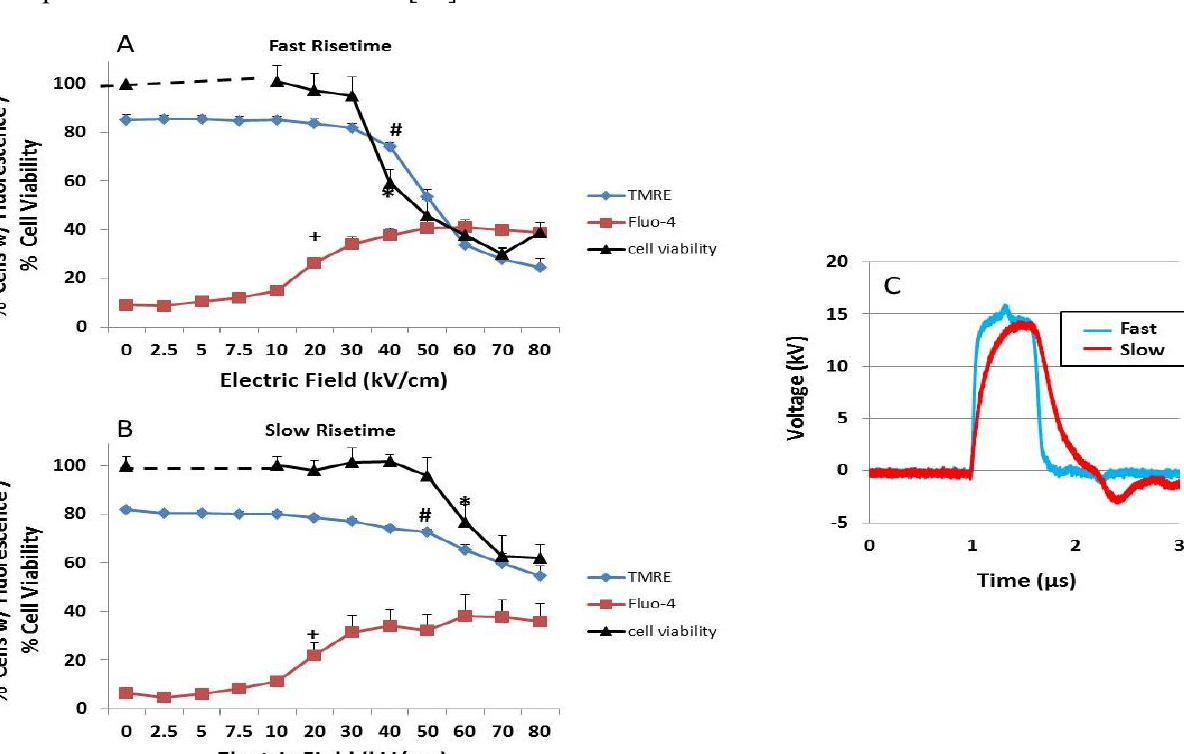
Figure 2. NsPEF fast rise- (cid:73)(cid:68)(cid:79)(cid:79)(cid:3)(cid:87)(cid:76)(cid:80)(cid:72)(cid:86)(cid:3)(cid:87)(cid:68)(cid:85)(cid:74)(cid:72)(cid:87)(cid:3)(cid:507)(cid:524)(cid:80)(cid:3)(cid:68)(cid:81)(cid:71)(cid:3) cell viability (cid:178) (A and B) N1-S1 HCC cells were loaded with Fluo-4 Direct to determine Ca 2+ influx (red squares) and with TMRE (cid:87)(cid:82)(cid:3) (cid:71)(cid:72)(cid:87)(cid:72)(cid:85)(cid:80)(cid:76)(cid:81)(cid:72)(cid:3) (cid:507)(cid:524)(cid:80)(cid:3) (cid:11)(cid:69)(cid:79)(cid:88)(cid:72)(cid:3) (cid:71)(cid:76)(cid:68)(cid:80)(cid:82)(cid:81)(cid:71)(cid:86)(cid:12)(cid:3) (cid:69)(cid:92)(cid:3) (cid:73)(cid:79)(cid:82)(cid:90)(cid:3) (cid:70)(cid:92)(cid:87)(cid:82)(cid:80)(cid:72)(cid:87)(cid:85)(cid:92)(cid:3) (cid:68)(cid:86)(cid:3) (cid:71)(cid:72)(cid:86)(cid:70)(cid:85)(cid:76)(cid:69)(cid:72)(cid:71)(cid:3) (cid:76)(cid:81)(cid:3) (cid:87)(cid:75)(cid:72)(cid:3) (cid:40)(cid:91)(cid:83)(cid:72)(cid:85)(cid:76)(cid:80)(cid:72)(cid:81)(cid:87)(cid:68)(cid:79)(cid:3) Section. The Y-axis indicates the percentage of cells with fluorescence for either Fluo-4 or TMRE, which were determined 10 minutes after nsPEF treatment. In parallel experiments, the percentage of viable cells (black triangles) was determined 24 hours after treatment as described in the Experimental section. (C) Cells were treated with one 600 ns pulse with a 15 ns fast rise-fall time waveform (blue line, panel A) or a 150 ns slow rise-fall time waveform (red line, panel B) at the indicated electric fields. For Panels A and B significant differences from control sham (cid:87)(cid:85)(cid:72)(cid:68)(cid:87)(cid:80)(cid:72)(cid:81)(cid:87)(cid:3)(cid:68)(cid:85)(cid:72)(cid:3)(cid:76)(cid:81)(cid:71)(cid:76)(cid:70)(cid:68)(cid:87)(cid:72)(cid:71)(cid:3)(cid:73)(cid:82)(cid:85)(cid:3)(cid:68)(cid:79)(cid:79)(cid:3)(cid:72)(cid:79)(cid:72)(cid:70)(cid:87)(cid:85)(cid:76)(cid:70)(cid:3)(cid:73)(cid:76)(cid:72)(cid:79)(cid:71)(cid:86)(cid:3)(cid:149)(cid:3)(cid:87)(cid:75)(cid:72)(cid:3)(cid:86)(cid:92)(cid:80)(cid:69)(cid:82)(cid:79)(cid:3)(cid:73)(cid:82)(cid:85)(cid:3) Fluo-4 (+p < 0.001, n = 3,); for TMRE ( # p < 0.03, n = 3) and cell viability (* p < 0.001, n = (cid:22)(cid:12)(cid:17)(cid:3) (cid:11)(cid:38)(cid:82)(cid:85)(cid:85)(cid:72)(cid:70)(cid:87)(cid:76)(cid:82)(cid:81)(cid:29)(cid:3) (cid:36)(cid:49)(cid:50)(cid:57)(cid:36)(cid:3) (cid:90)(cid:76)(cid:87)(cid:75)(cid:3) (cid:55)(cid:88)(cid:78)(cid:72)(cid:92)(cid:182)(cid:86)(cid:3) (cid:70)(cid:82)(cid:85)(cid:85)(cid:72)(cid:70)(cid:87)(cid:76)(cid:82)(cid:81) ). These data have been previously published in a different format